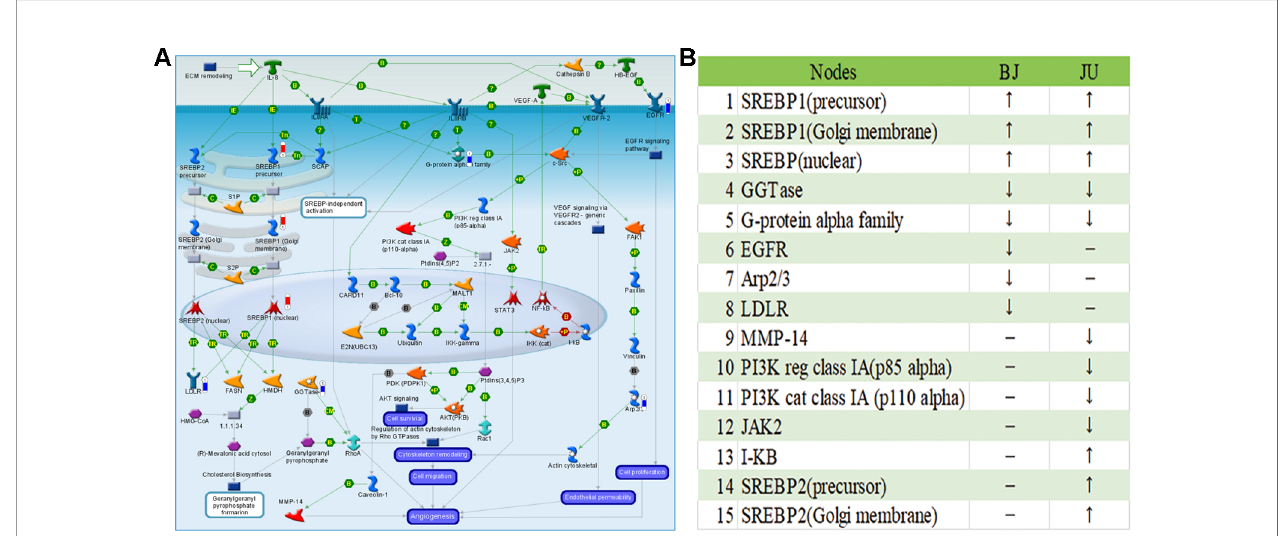
FIGURE 4 | The “ Development_Role of IL-8 in angiogenesis ” pathway was shared by BJ and JU groups. (A) Differentially expressed genes regulating by BJ were labeled as thermometer-like fi gures, up-ward red thermometers indicate up-regulated signals, with height corresponding to signi fi cance level. The map legend can be viewed at http://pathwaymaps.com/pdf/ MC_legend.pdf. (B) The common and different targets regulated by BJ and JU